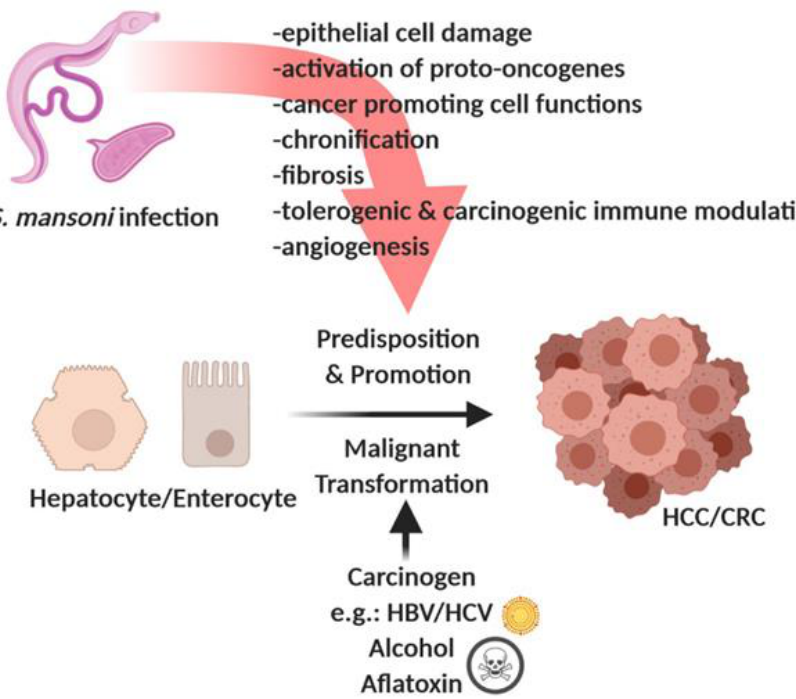
Figure 1. Infection with S. mansoni induces processes predisposing a patient to malignant transfor- mation and/or promoting hepatocellular carcinogenesis (HCC) and/or colorectal carcinogenesis (CRC). Created with BioRender.com, online link: https://biorender.com/, (accessed on 25 March